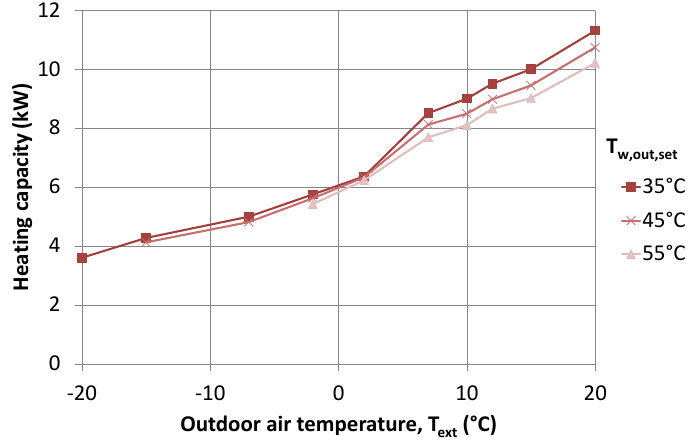
Figure 3. Heating capacity simulation (lines) and catalogue (dots) data.